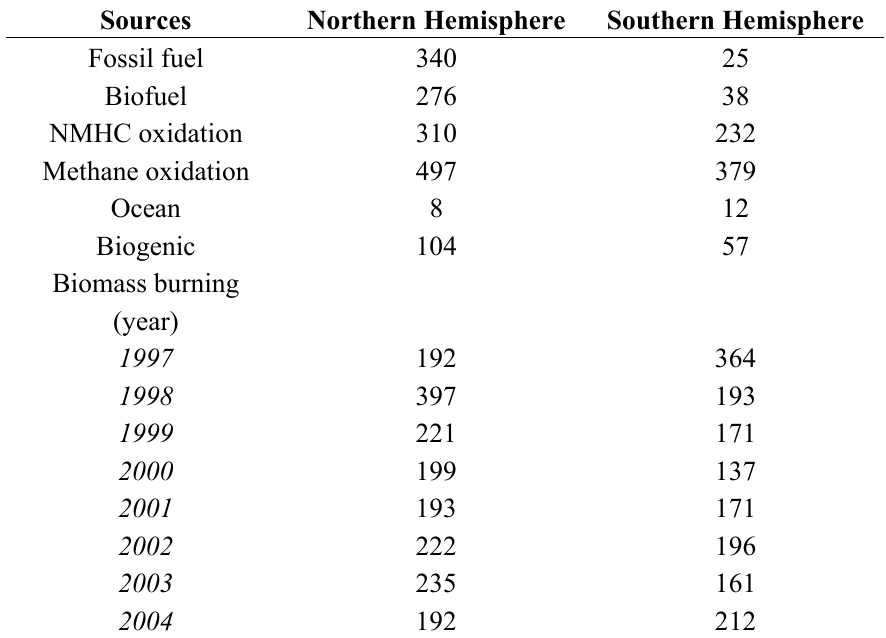
Table 1. Annual mean of a priori source strengths used in this study (TgCO/year). Global Fire Emissions Database version 2 (GFED-v2) inventory is used for biomass burning carbon monoxide